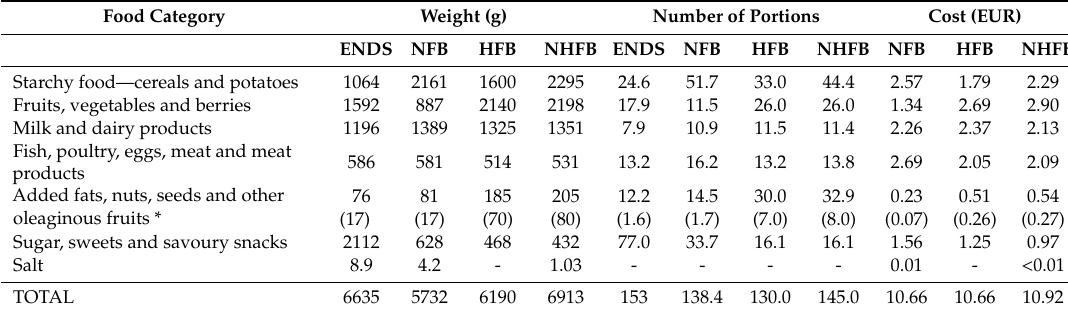
Table 5. The weights, number of portions, and cost of food categories in the food baskets (FB) that are nutritionally adequate (NFB), include the Estonian food-based dietary guidelines (FBDG) only (HFB), and are both nutritionally adequate and include the Estonian FBDG (NHFB) per day compared with the Estonian National Dietary Survey (ENDS).